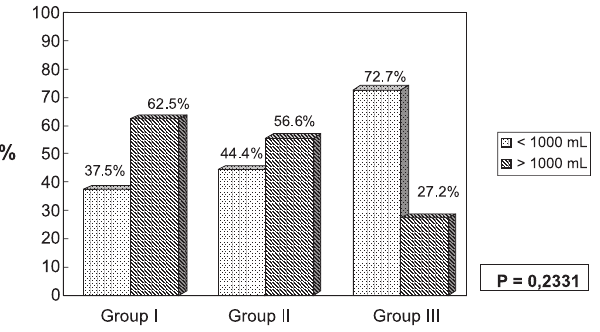
Figure 2 - Irrigating fluid absorption in the three